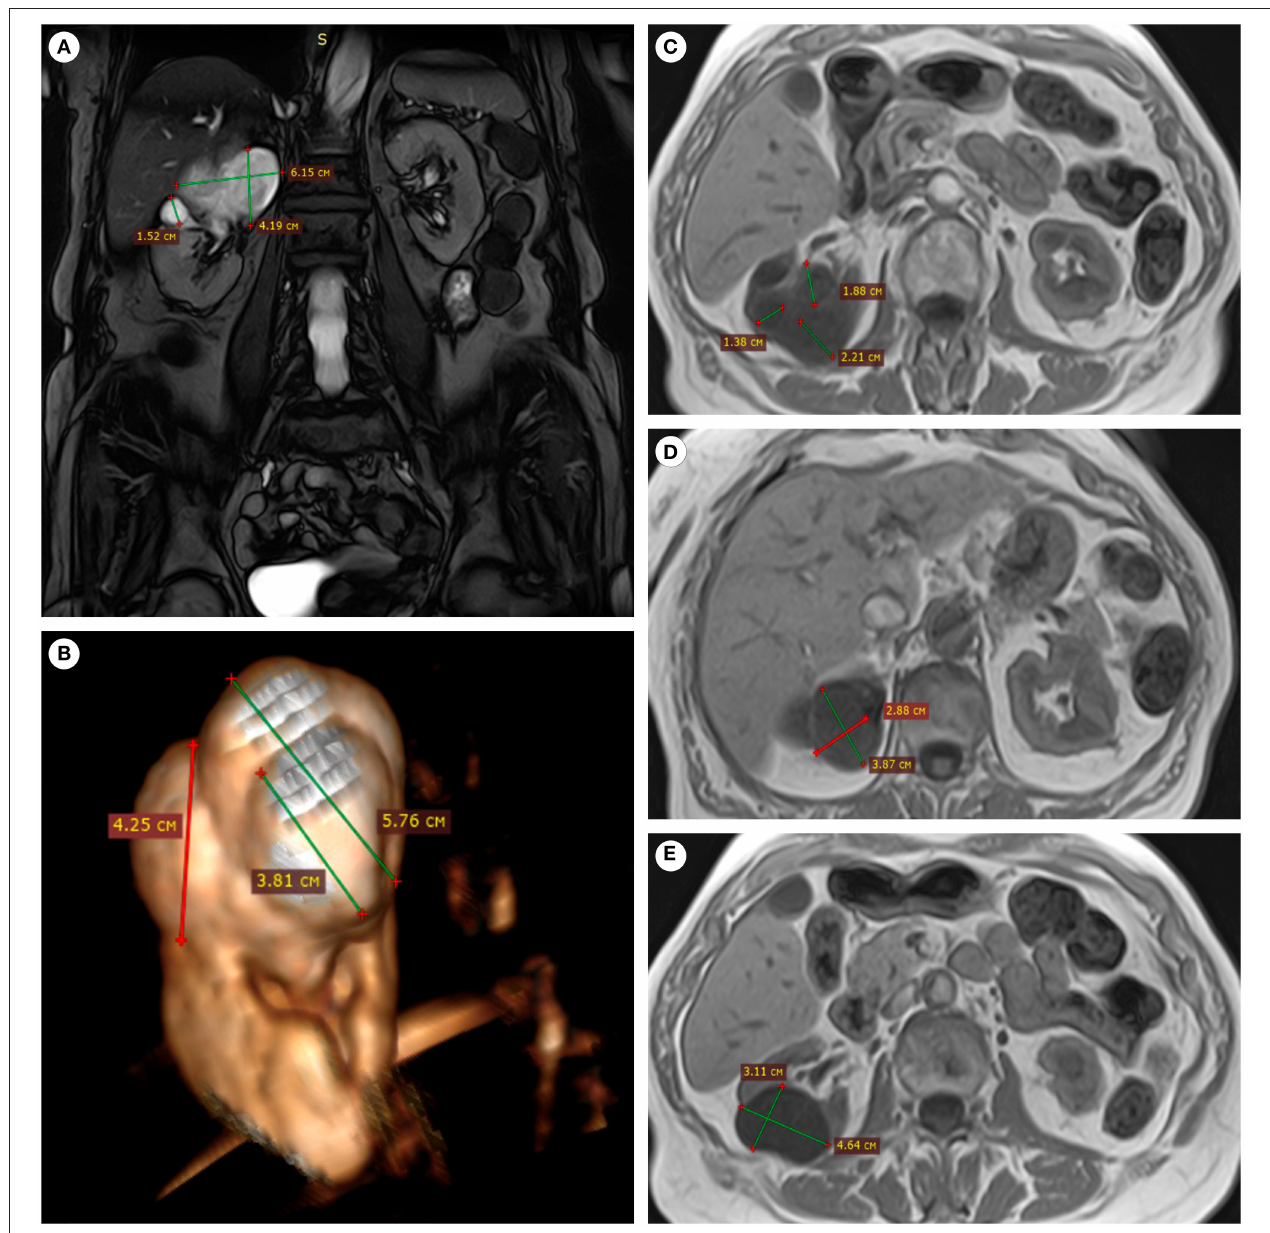
FIGURE 1 | MRI of the patient’s abdominal cavity (without contrast). (A) In the upper pole of the right kidney, the lesion of an irregular shape and inhomogeneous structure was connected with the pelvicalyceal system, coronal projection, SSFP mode. (B) The lesion had an irregular shape and a bumpy surface, 3D-reconstruction from the SSFP series. (C–E) The multinodular nature of the lesion and clear boundaries were determined in axial sections, T1 mode.